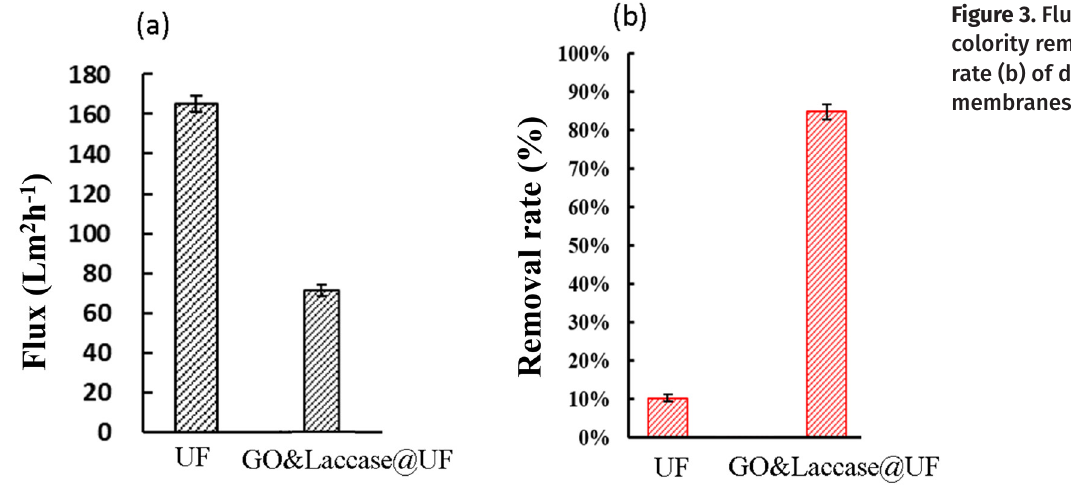
Figure 3. Flux (a) and colority removal rate (b) of different membranes.